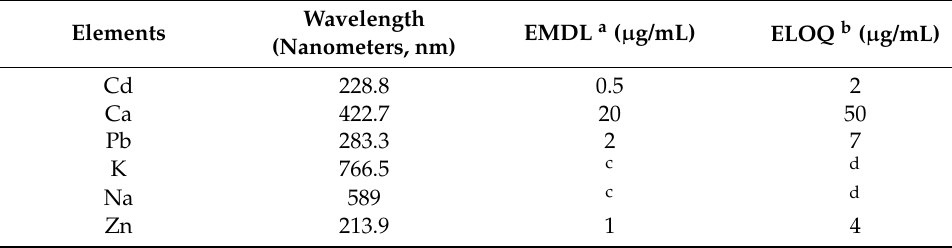
Table 2. Summary of EMDL and